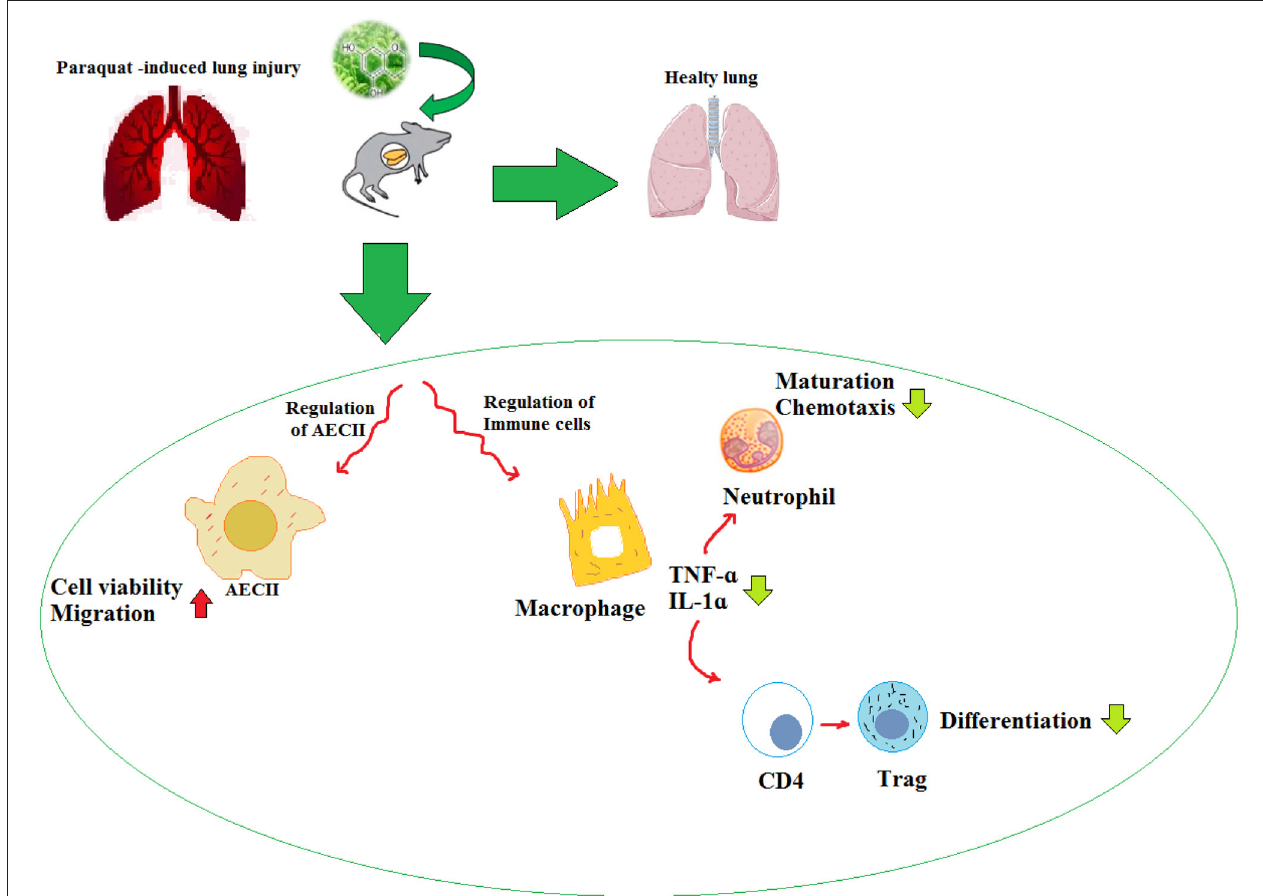
FIGURE 4 | Inhibitory effects of NP on PQ-induced pulmonary